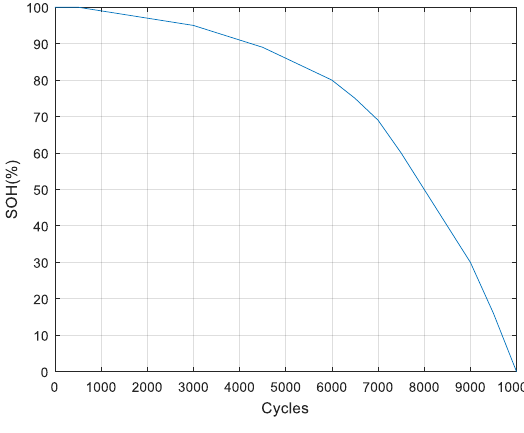
Figure 5. SC cycle performance.